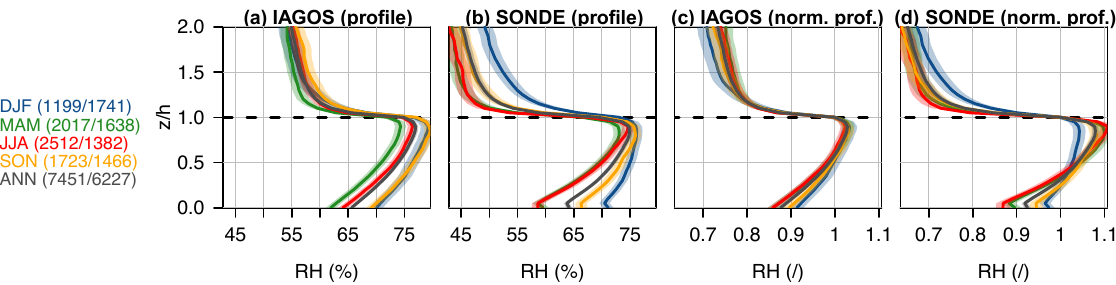
Figure 10. IAGOS and ozonesonde PBL-referenced ( a, b ) and normalized profiles ( c, d ) of daytime RH. The number of profiles accounted for is indicated for each season (in brackets: IAGOS /